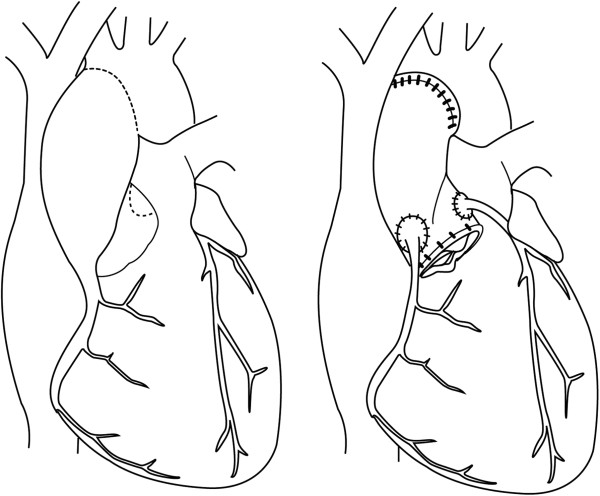
Bentall procedure.